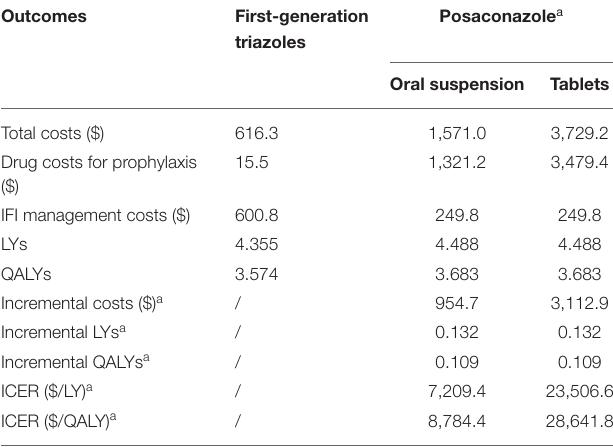
TABLE 2 | Cost-effectiveness results of posaconazole vs. first-generation triazoles.